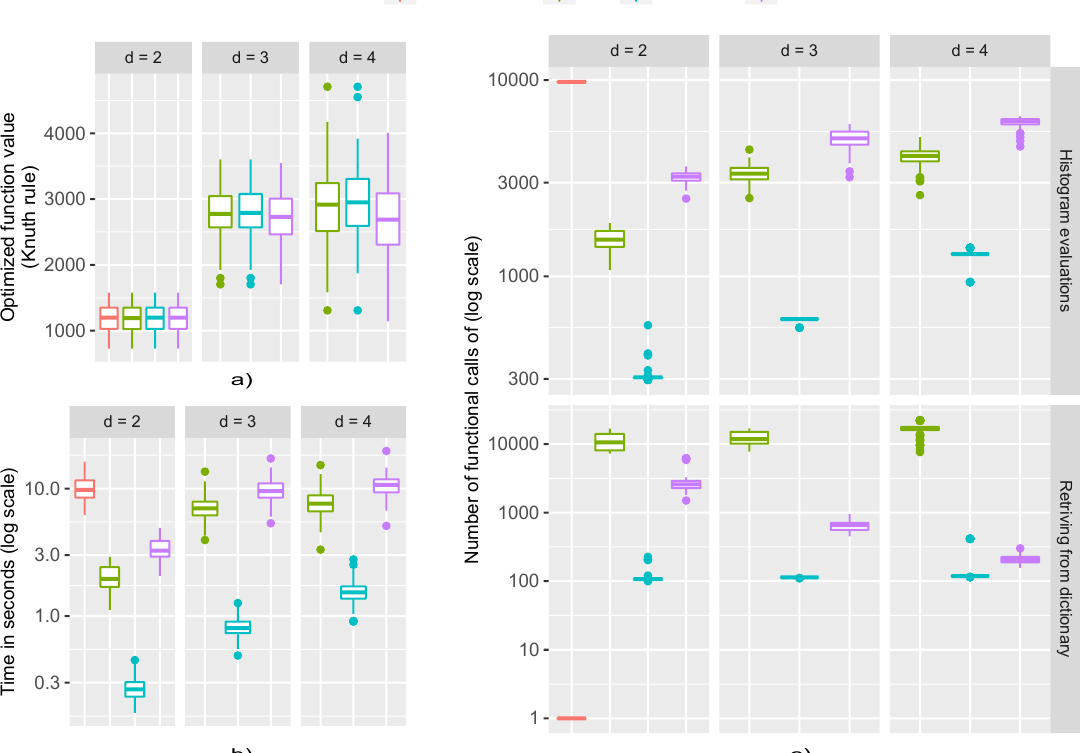
Figure 3. Results obtained from the first experiment: ( a ) Optimization-function value—the Knuth rule defined in Equation (22), for each algorithm and dimension of the dataset d . ( b ) Time spent for each algorithm to obtain optimum binning v opt for each dimension of the dataset d . ( c ) Number of true function evaluation calls; i.e., histogram evaluations vs. the number of silent function evaluation calls; i.e., retrieving the stored value from memoization dictionary for each algorithm and dimension of the dataset d